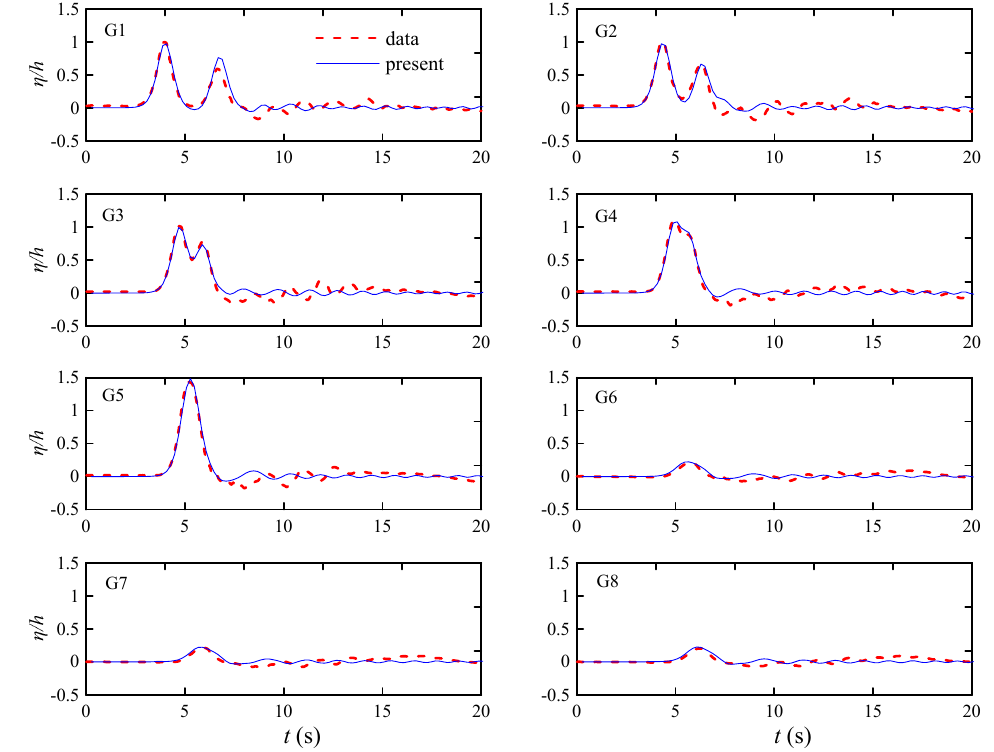
Figure 5. Comparison of free surface elevation between present simulation (solid line) and experimental data (dashed line) for Case S2 ( H / h = 0.22).